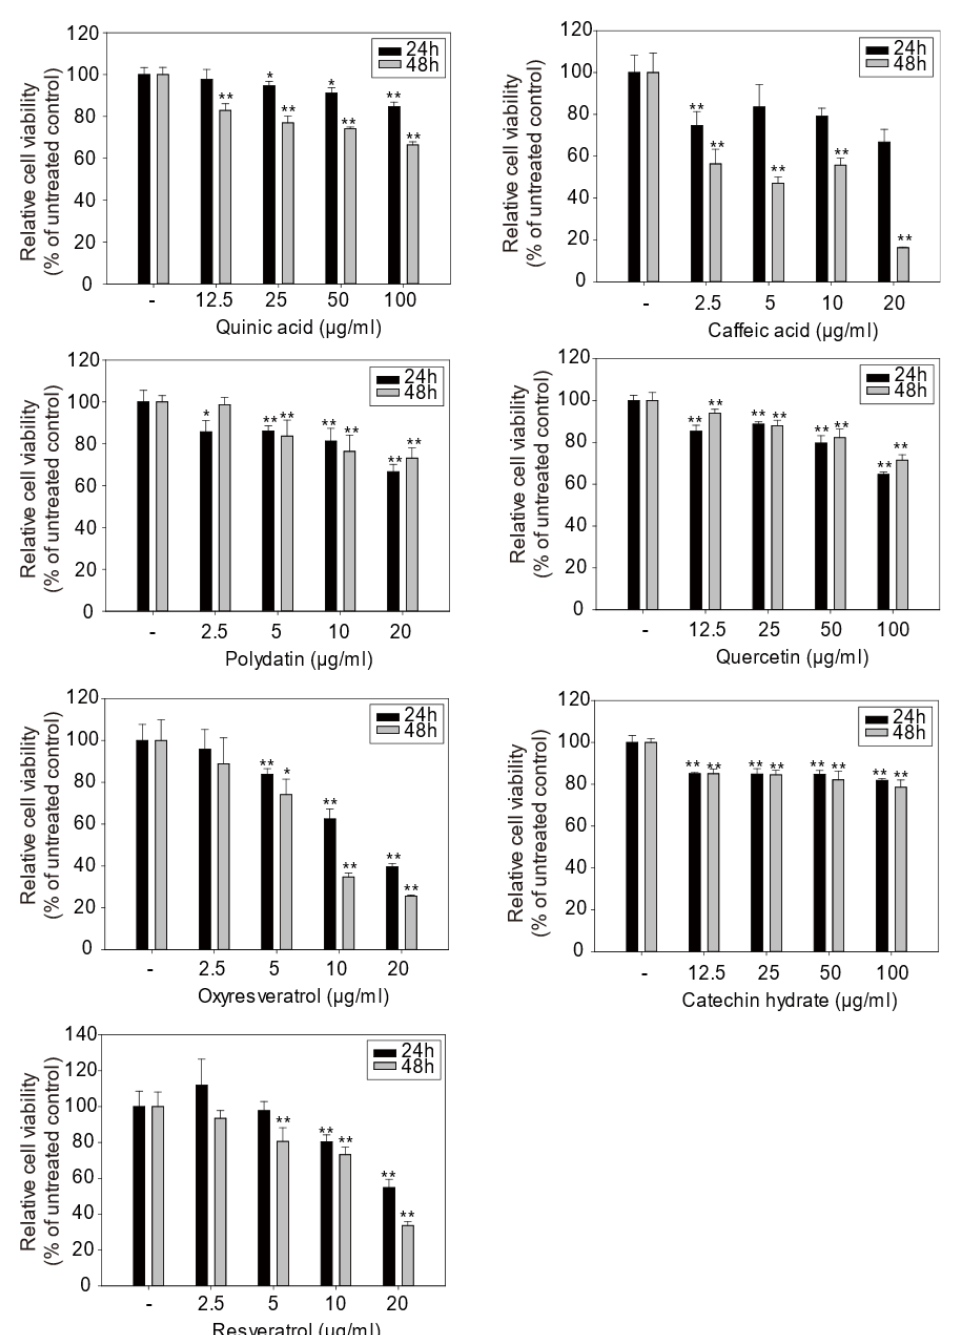
Figure 5. Cell viability of each chemical on skin keratinocyte HaCaT cells. Cell viability was measured using the MTT assay described in Materials and Methods. Data are shown as mean ± SD and asterisks (*) indicate a significant inhibition by each compound compared with the untreated control group (*, p < 0.05 and **, p < 0.01).